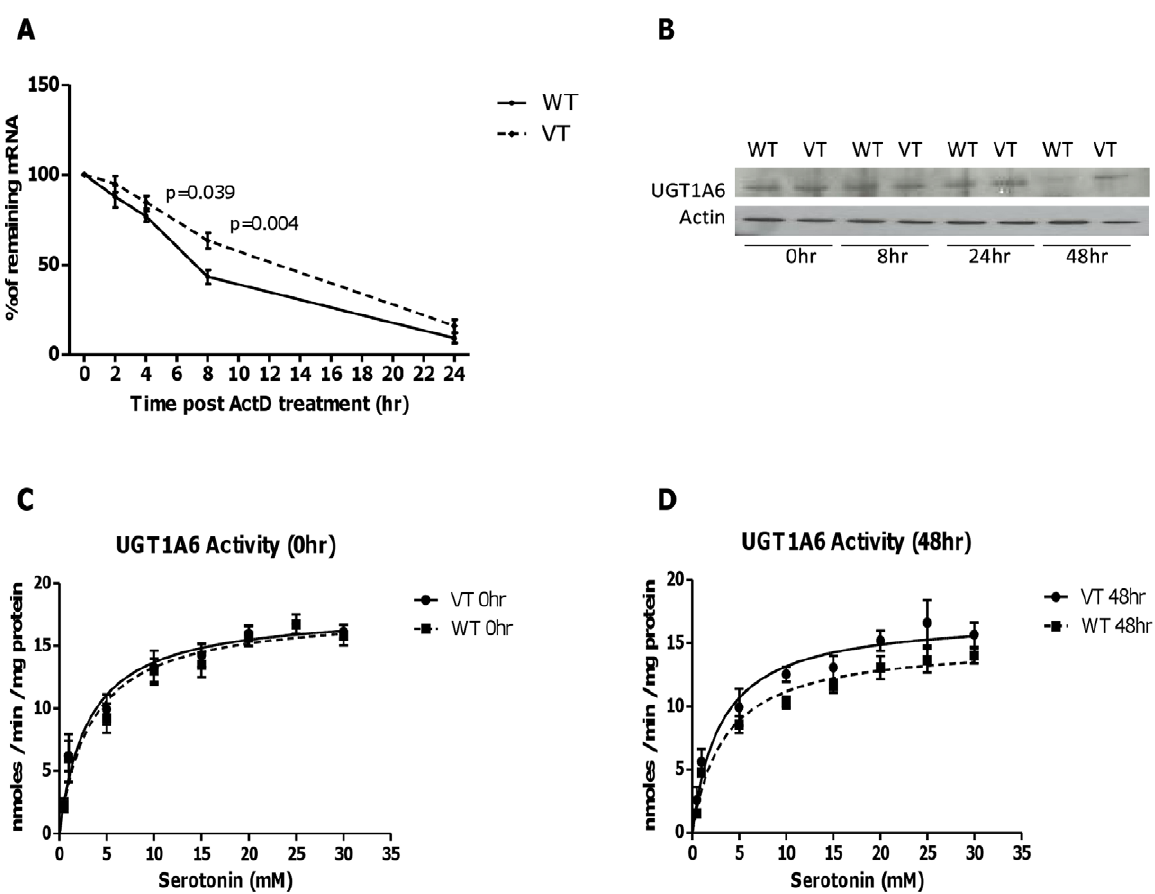
Figure 1. In vitro functional characterization of UGT1A6 105C . T polymorphism. UGT1A6*1 and UGT1A6 105TT constructs were stably transfected into HEK293 cells. ( A ) Cells were harvested upon treatment with ActD at different time point up to 24 hours. The data plotted are time course changes in the remaining amount of UGT1A6 mRNA after ActD treatment. There was significantly higher mRNA level in UGT1A6 105TT than UGT1A6*1 transfected cells at 4 hours (p=0.039) and 8 hours (p=0.004) after treatment with ActD. ( B ) Western blot analysis. Cell lysate used was from 5 6 10 5 cells at the indicated times (0, 8, 24 and 48 hours) after treatment with ActD. There was a down-regulation in protein expression in UGT1A6*1 as compared to UGT1A6 variant at 48 hours after treatment with ActD. UGT1A6 activity was assessed by evaluating the production of serotonin glucuronide using lysate from variant UGT1A6 (VT) and UGT1A6*1 (WT) at 0 hour ( C ) and 48 hours ( D ) after ActD treatment, with substrate concentrations varied from 0.5 to 30 mM serotonin. Activities are expressed as reaction velocity (nanomoles of serotonin glucuronide formed per minute per milligram of protein).